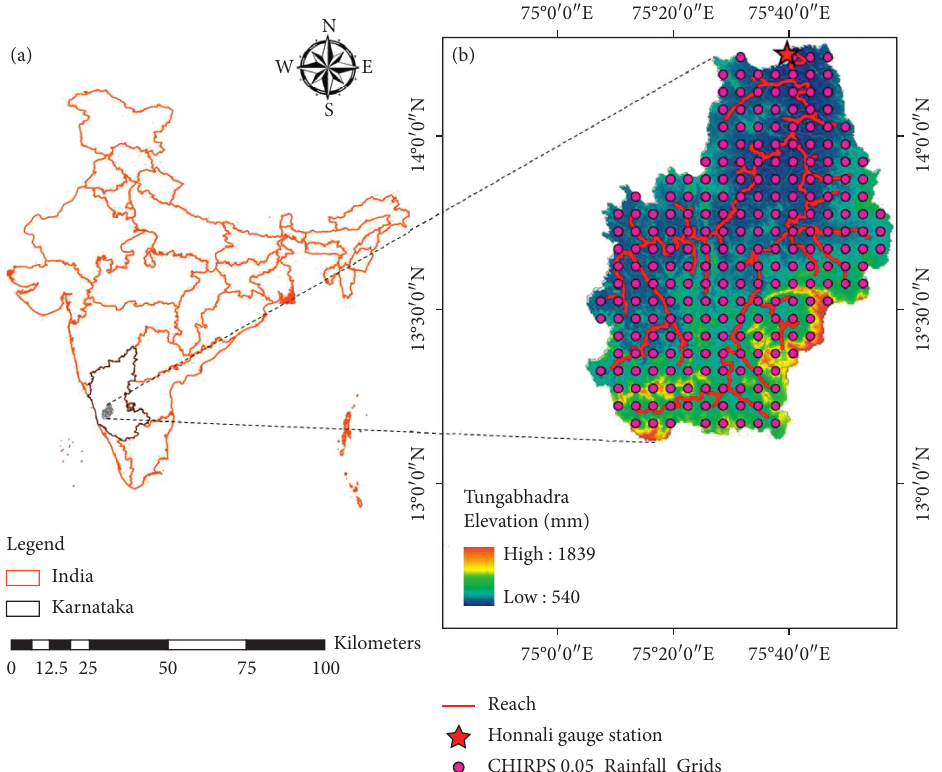
Figure 1: (a) Study area map of India and Karnataka. (b) DEM of Tungabhadra along with CHIRPS 0.05 ° rainfall data grids, Honnali gauge station, and Tungabhadra river